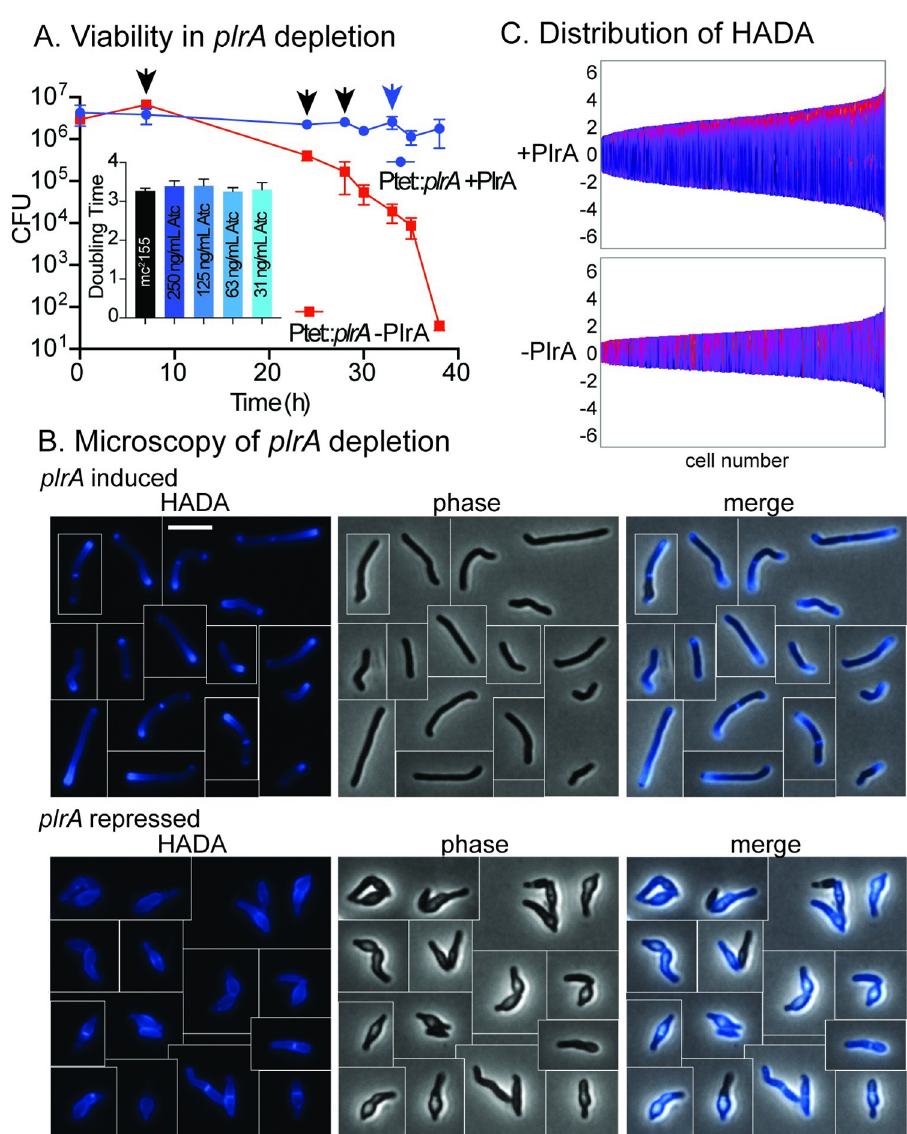
Fig 1. PlrA is an essential polar growth regulator. A) CFU of the Ptet:: plrA strain in the presence ( plrA induced) or absence ( plrA repressed) of inducer Atc. Three independent replicate cultures were used for each condition. Black arrows represent when dilutions were performed in both cultures to prevent them reaching stationary phase. Blue arrow indicates when dilution was performed in the +Atc (+PlrA) culture only. Inset: Doubling time calculations from growth curves of the Msmeg mc 2 155 wild-type strain (black) and the Ptet:: plrA strain induced with the indicated concentrations of Atc (shades of blue). A one-way ANOVA test with multiple comparisons shows that there are no significant differences between any of the presented doubling time measurements. B) Micrographs of a Ptet:: plrA strain with plrA induced (top, +Atc) or repressed (bottom, -Atc), then stained with the fluorescent D-alanine HADA for 15 minutes. Cells from different images were cut and pasted together so that a representative collection of cells could be shown. The scale bar on the top left image is 5 microns, and applies to all images. C) Demographs of fluorescent images from the same experiment as cells in panel B. HADA intensity is indicated by color, with bright colors representative of high intensity, and dark color representing lower intensity. Intensity along the length of cells (Y axis of demograph) in plrA induced (top) and depleted (bottom) cells. Cells were sorted by size (X axis of demographs) and pole sorted, so that brightest pole is set at the